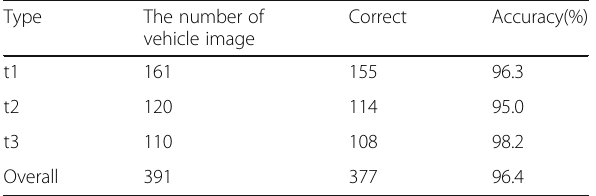
Table 6 Accuracy of vehicle classification by the visual image classifier (3 types)